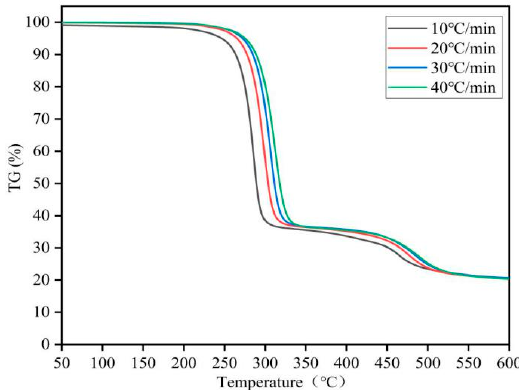
Figure 8. TG curves for the pyrolysis of PVC/CuAl-LDH-5% at different heating rates.